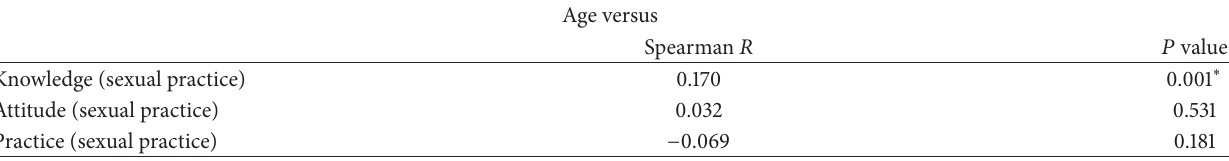
Table 5: Correlation between age and knowledge, attitude, and practice to sexual practice scores.